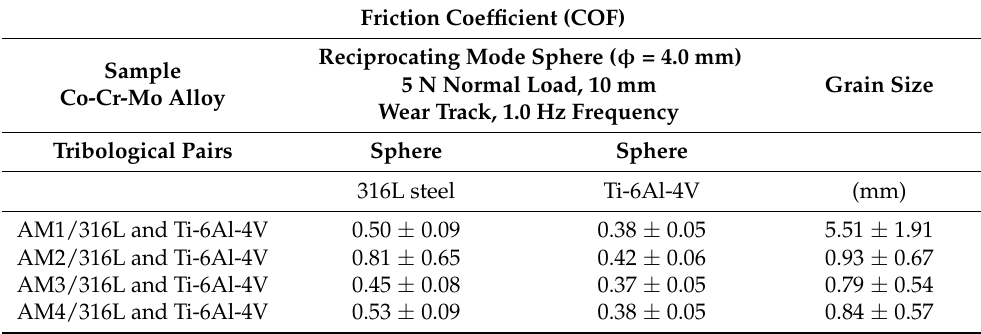
Table 3. Mean COF values obtained in the reciprocating sliding tests for the Co-Cr-Mo alloy samples. Additionally, the grain sizes of the samples are shown.